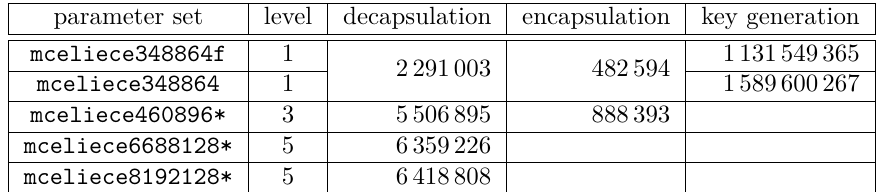
Table 12: Cycle counts for capable operations on stm32f4-Discovery at 24MHz. We use * to mean both the “non-f” parameter set (simply removing * ) and the corresponding “f” parameter set (replacing * by f). Note that a non-f parameter set and the corresponding f parameter set share the same encapsulation and decapsulation algorithms. The cycle counts for encapsulation and key generation are average numbers of 100 measurements.